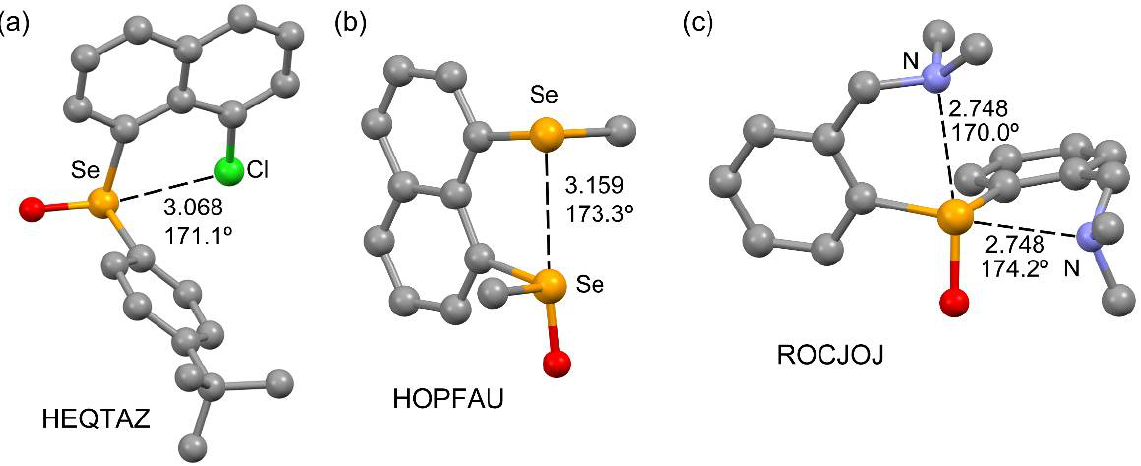
Figure 3. X-ray structures of HEQTAZ ( a ), HOPFAU ( b ), and ROCJOJ ( c ). H atoms omitted and distances in Å.